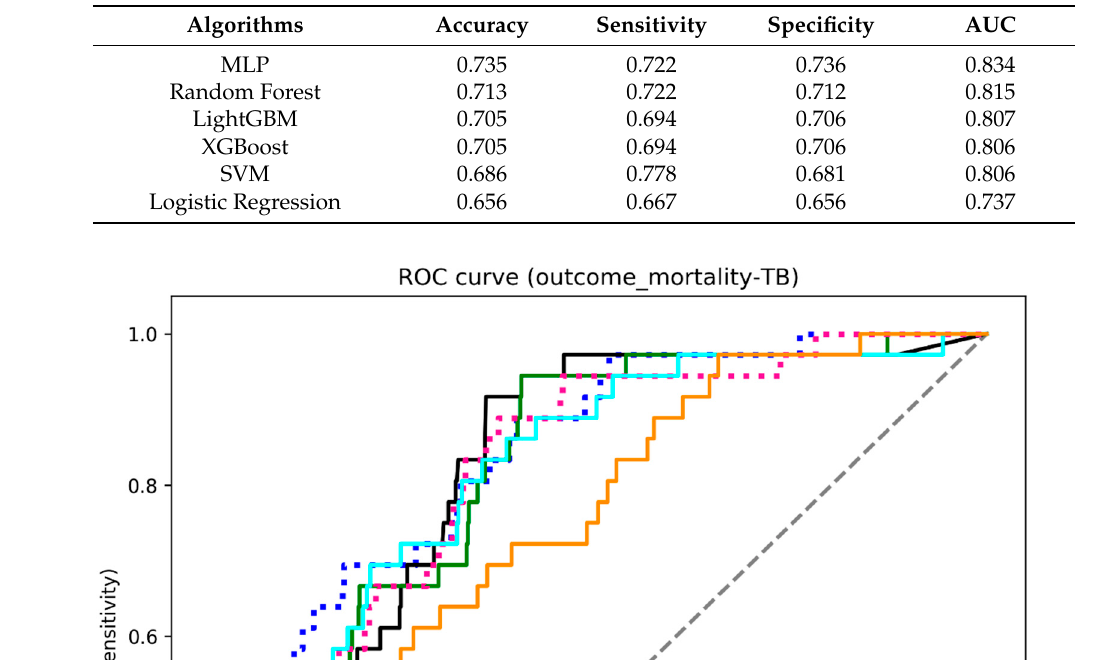
Table 2. Model results: mortality.